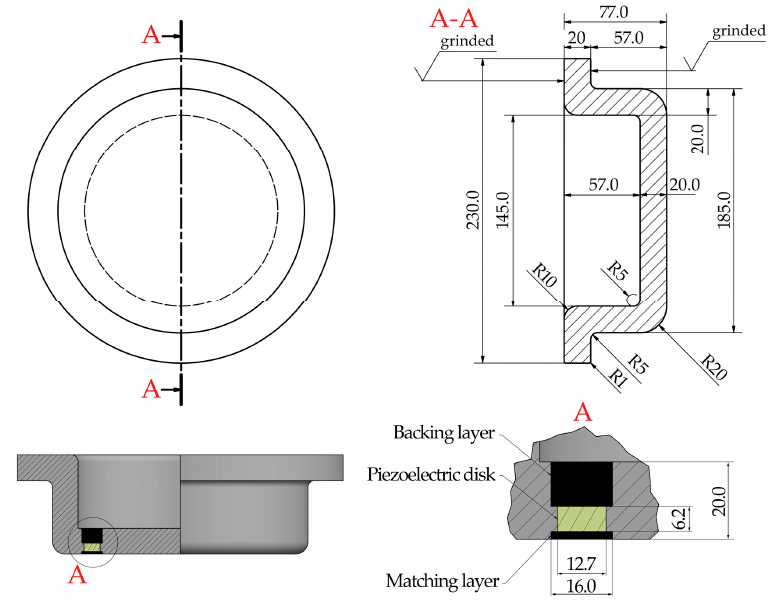
Figure 2. Technical drawing of the active dielectric window.